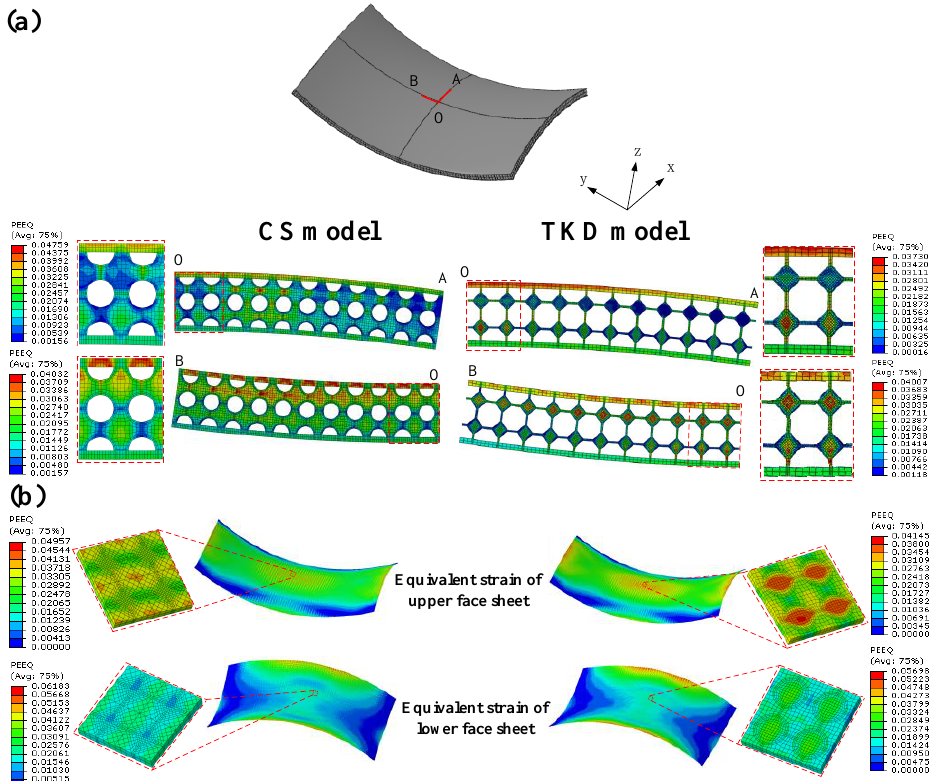
Figure 4. ( a ) Equivalent strain of cross section in the central region of saddle-shaped AFSP ( b ) Equiv- alent strain of upper and lower face sheet of saddle-shaped AFSP.